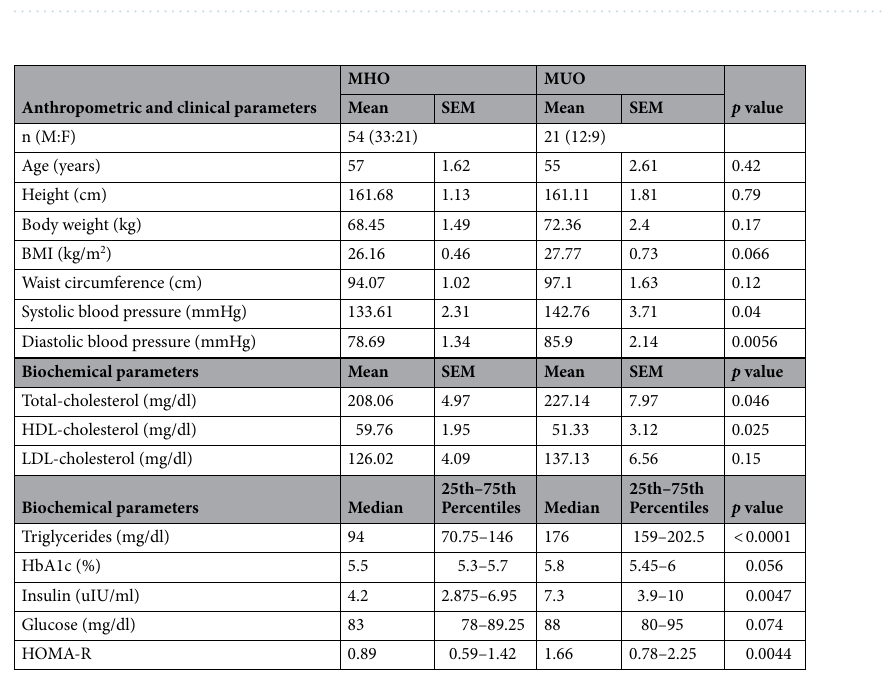
Table 2. Characteristics of MHO and MUO. Data were analyzed using unpaired t -test or Mann–Whitney U test to compare groups. MHO metabolic healthy obese, MUO metabolic unhealthy obese.